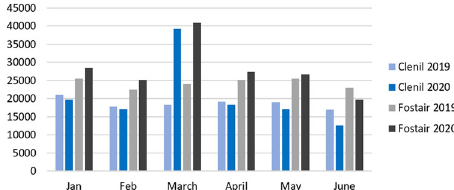
Fig. 2 The number of prescriptions by inhaler, month and year. Comparison of the number of prescriptions in March 2019 and March 2020 for the most highly prescribed ICS (Clenil Modulite 100 mcg) and LABA-ICS (Fostair